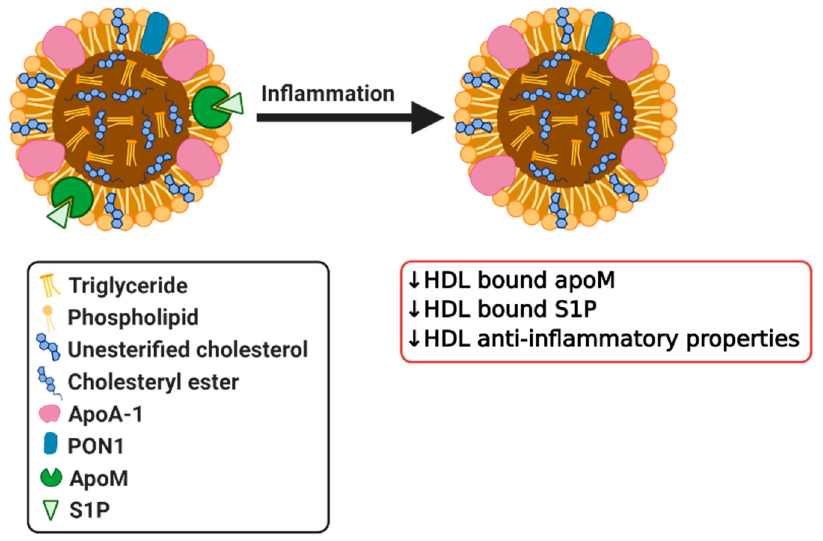
Figure 3. Simplified diagram of effects of inflammation on HDL bound apoM and sphingosine 1-phosphate (S1P) resulting in dysfunctional HDL.